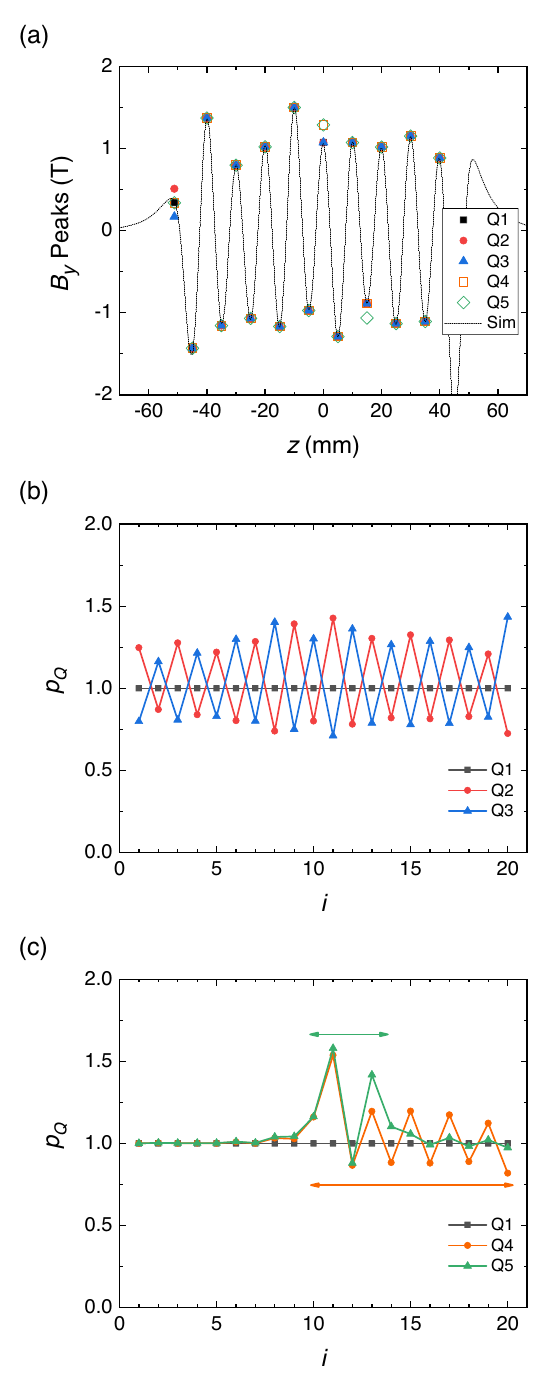
FIG. 10. The zigzag effect of the local offset to the inverse analysis; (a) five input data sets for the inverse analysis, and the estimated p for (b) the single positive or negative offset at the left end and (c) the single or double offset in the